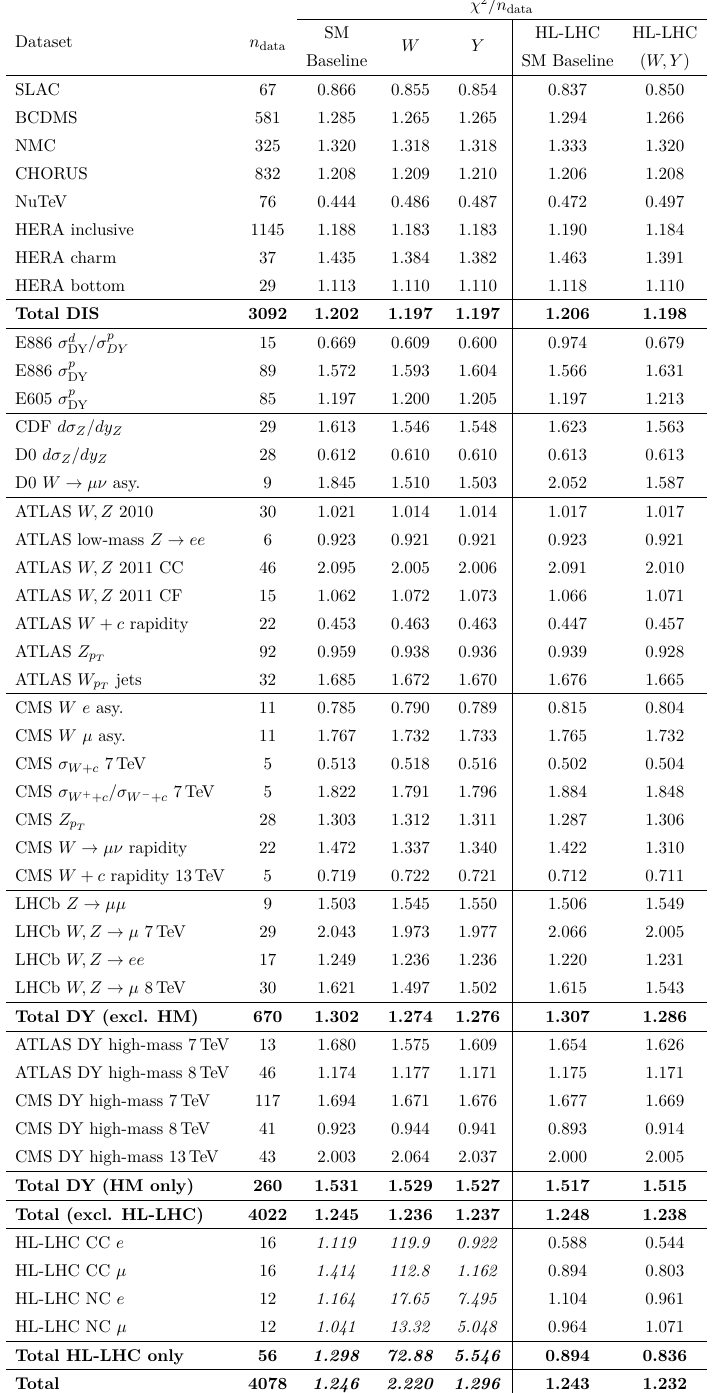
Table 5 . Values of the χ 2 per data point across all datasets used in this study. We tabulate values for the baseline PDF set as well as those obtained in the various SMEFT scenarios. Shown also is the χ 2 for the HL-LHC scenario. The rows indicating total χ 2 values are computed accounting for any relevant correlated systematic errors. Values in italics indicate the dataset was not used in the corresponding fit.